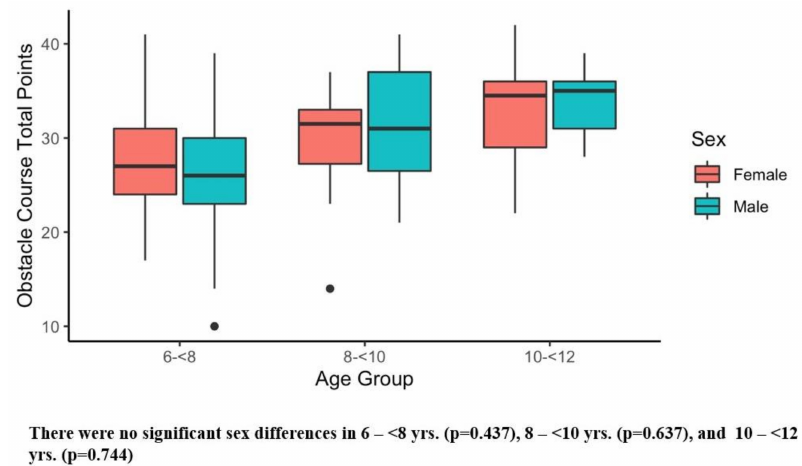
Figure 6. Obstacle Course Points. Black dots are